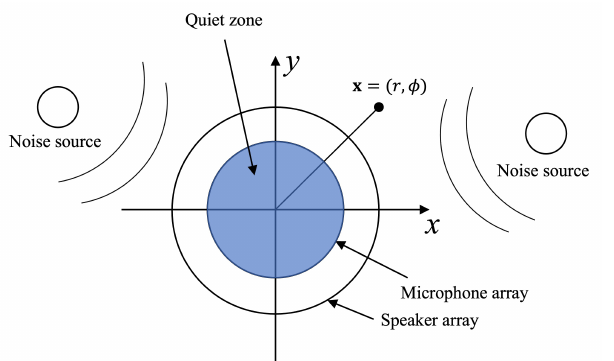
Figure 2. Proposed active noise control system based on the use of a single circular array with a quiet zone (blue